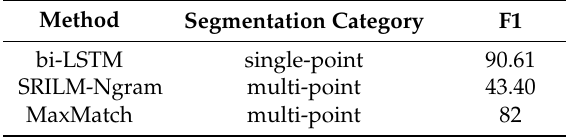
Table 1. Di ff erent morphology segmentation methods for Uyghur. Table 1. Different morphology segmentation methods for Uyghur.